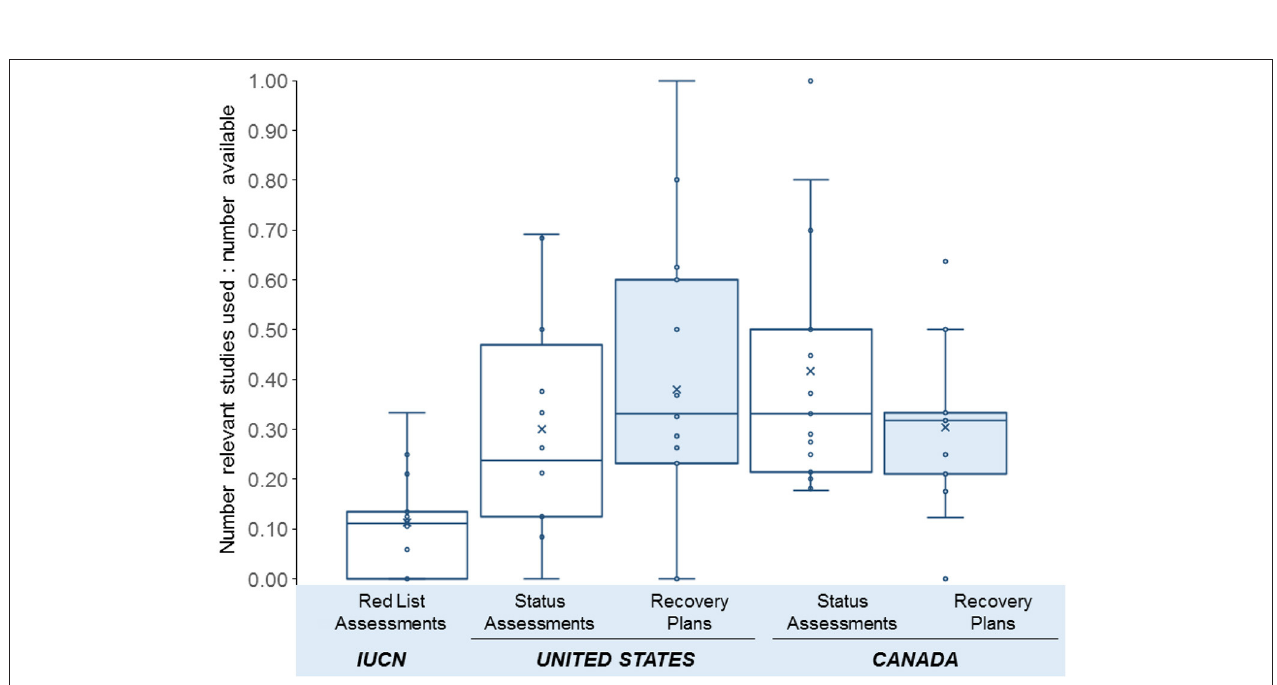
FIGURE 3 | Conservation assessments (open boxes) and recovery plans (shaded boxes) for threatened, transboundary species. Y-axis indicates the proportion of peer-reviewed studies used in conservation assessments to relevant, peer-reviewed studies available, for a subset of 12 species ( Figure 2 ) that have been assessed globally, by the IUCN, federally within the U.S.A., and federally within Canada. Boxes show the first (lower) and third (upper) quartiles; whiskers show adjacent values. Central lines indicate the median value; X indicates the mean.